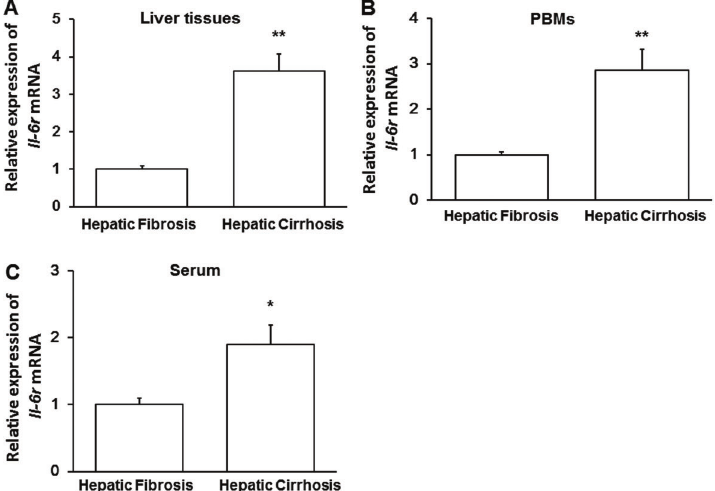
Figure 1. Real-time PCR analysis of Il-6r mRNA expression. A , Liver tissues; B , peripheral blood monocytes (PBMs), and C , serum from hepatitis B patients with liver fi brosis or liver. Data are reported as means ± SD. *P o 0.05 and **P o 0.01, one-way